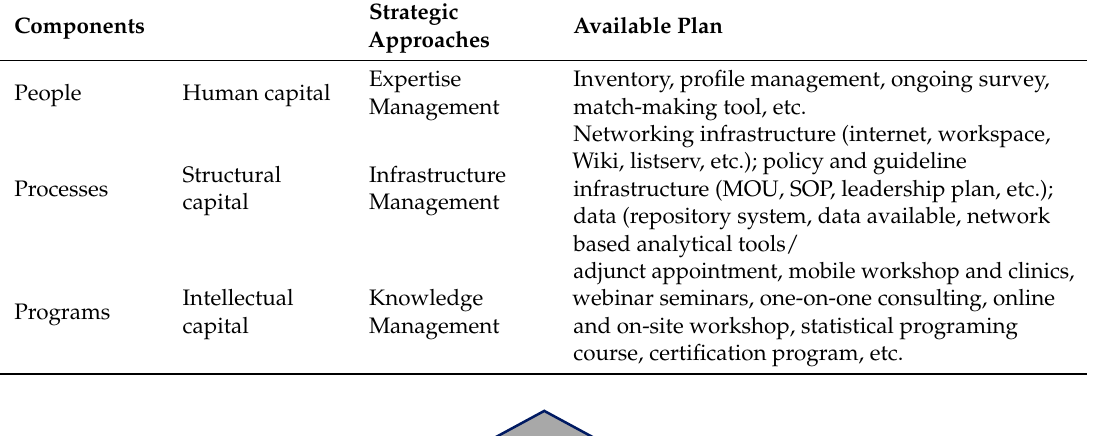
Table 1. Strategic Approaches and action plan per component.